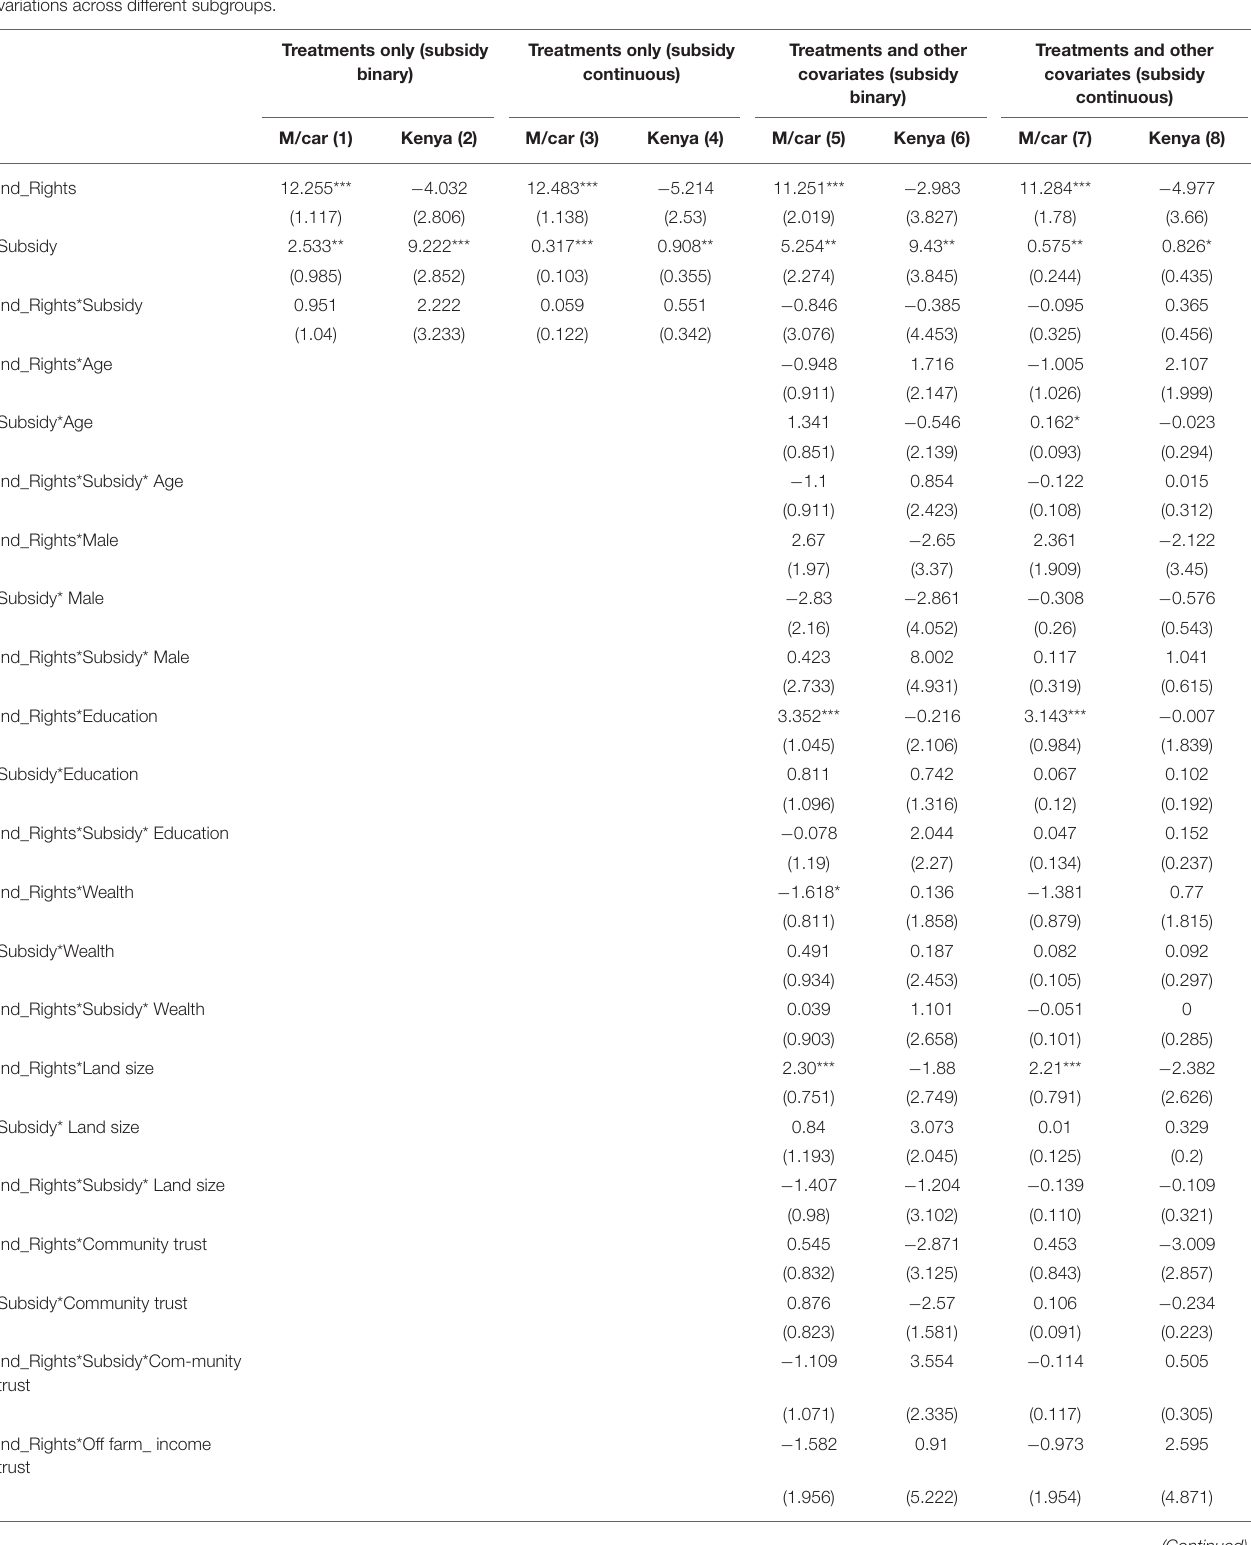
TABLE 3 | Estimates from the fixed effect panel data model showing the effects of the treatments on individual participant decisions to keep forest/fallow and their variations across different subgroups.